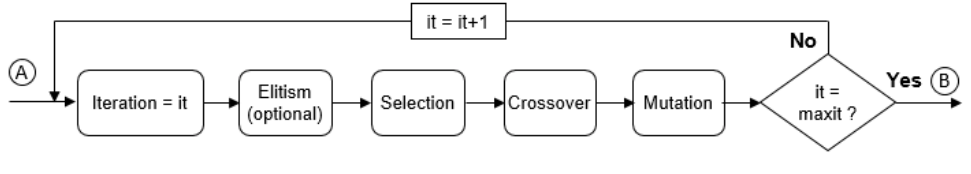
Figure 2. The flowchart of a GA iteration.